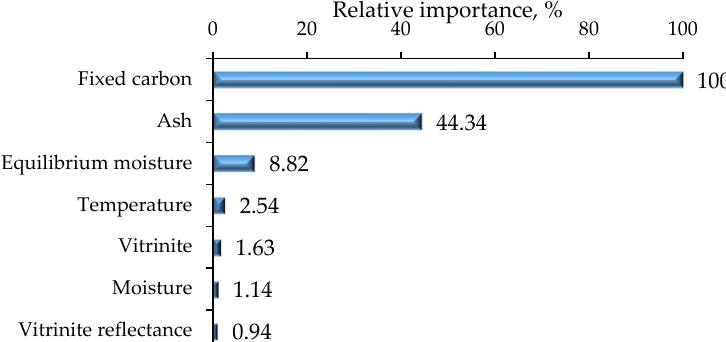
Figure 10. Relative importance of the input variables to the adsorption isotherm.